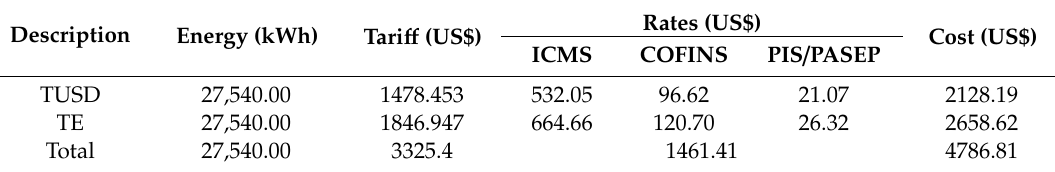
Table 4. Energy costs according to the conventional tari ff for company A